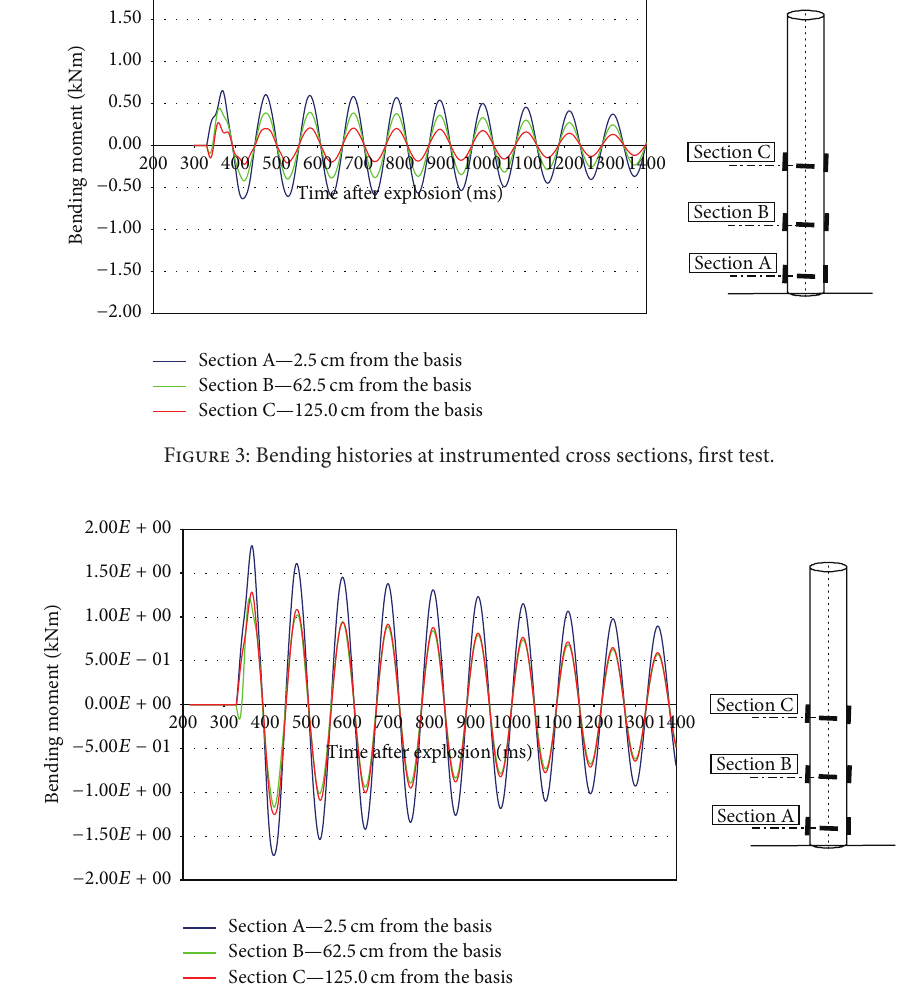
Figure 4: Bending histories at instrumented cross sections, second